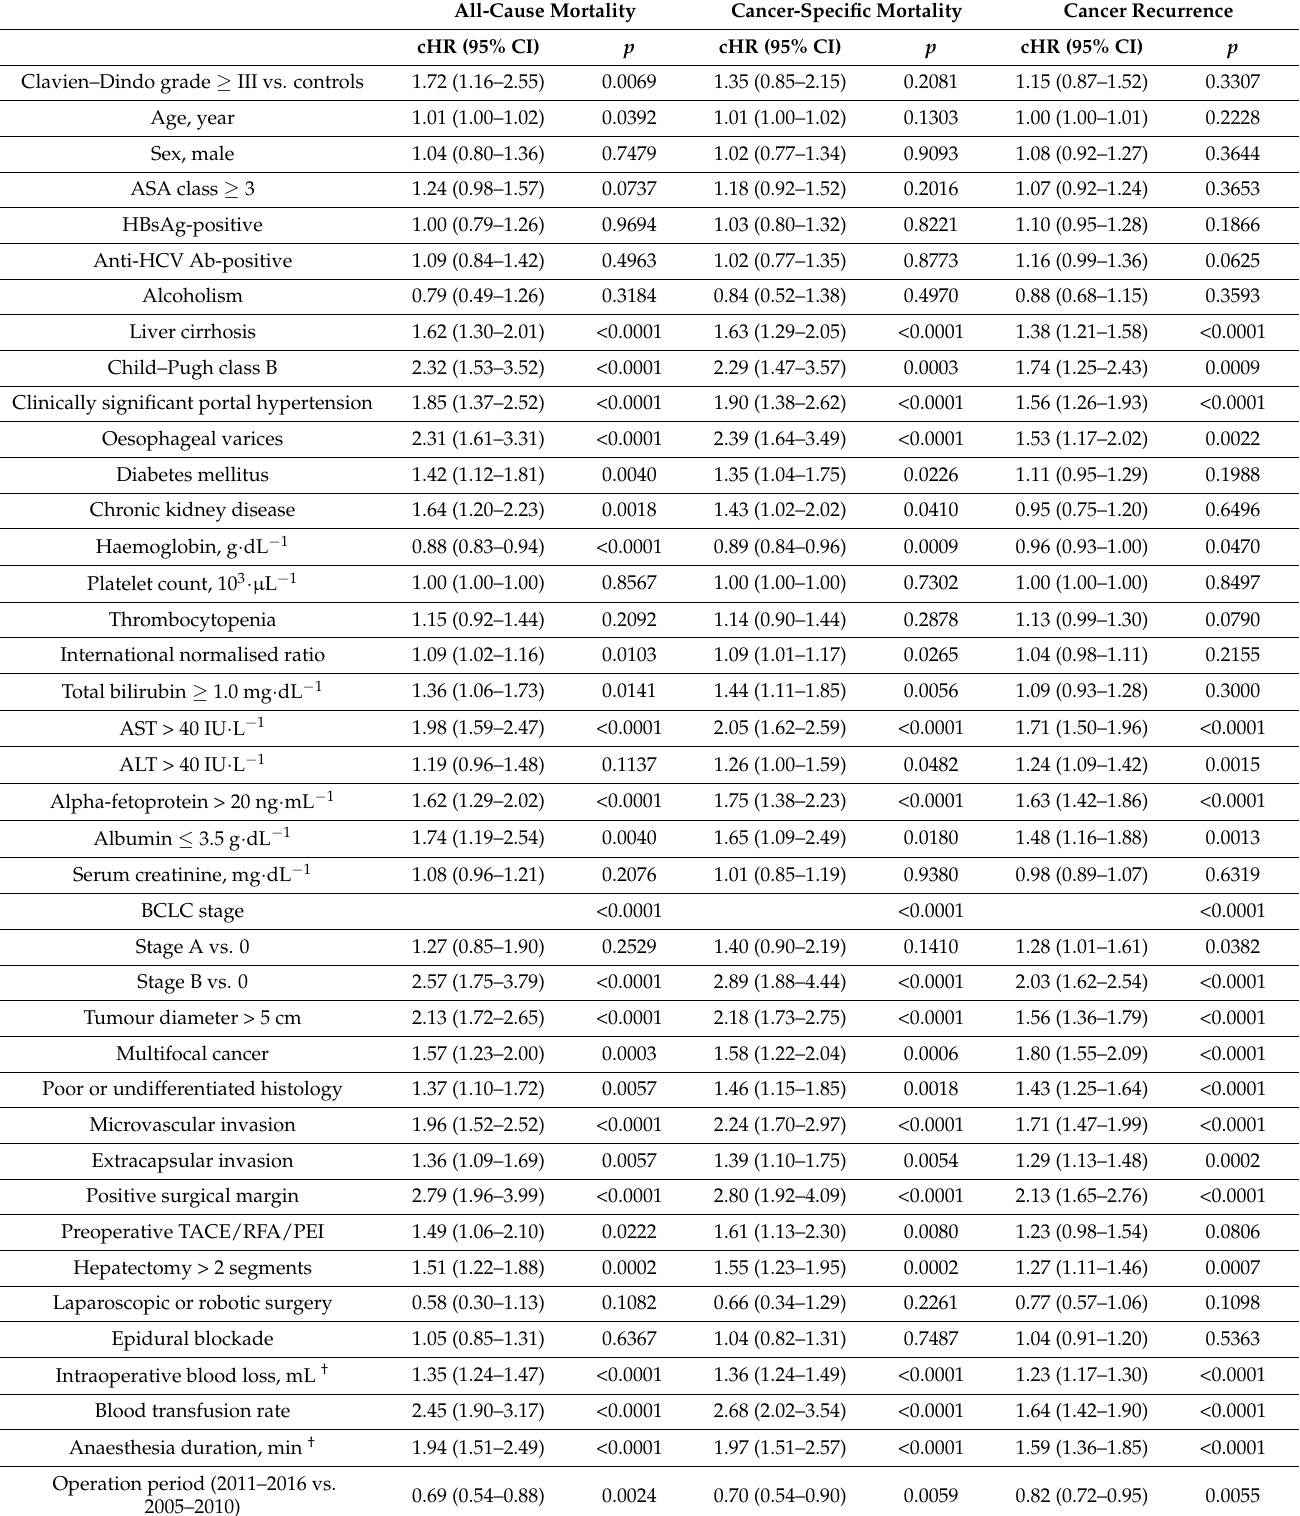
Table 3. Univariate analysis of mortality and cancer